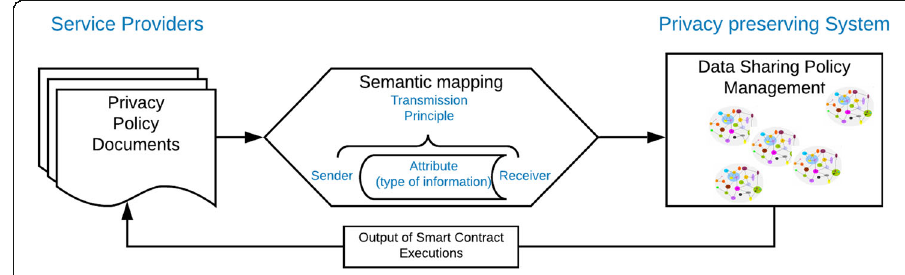
Fig. 9 Mapping privacy policy documents to personal data sharing